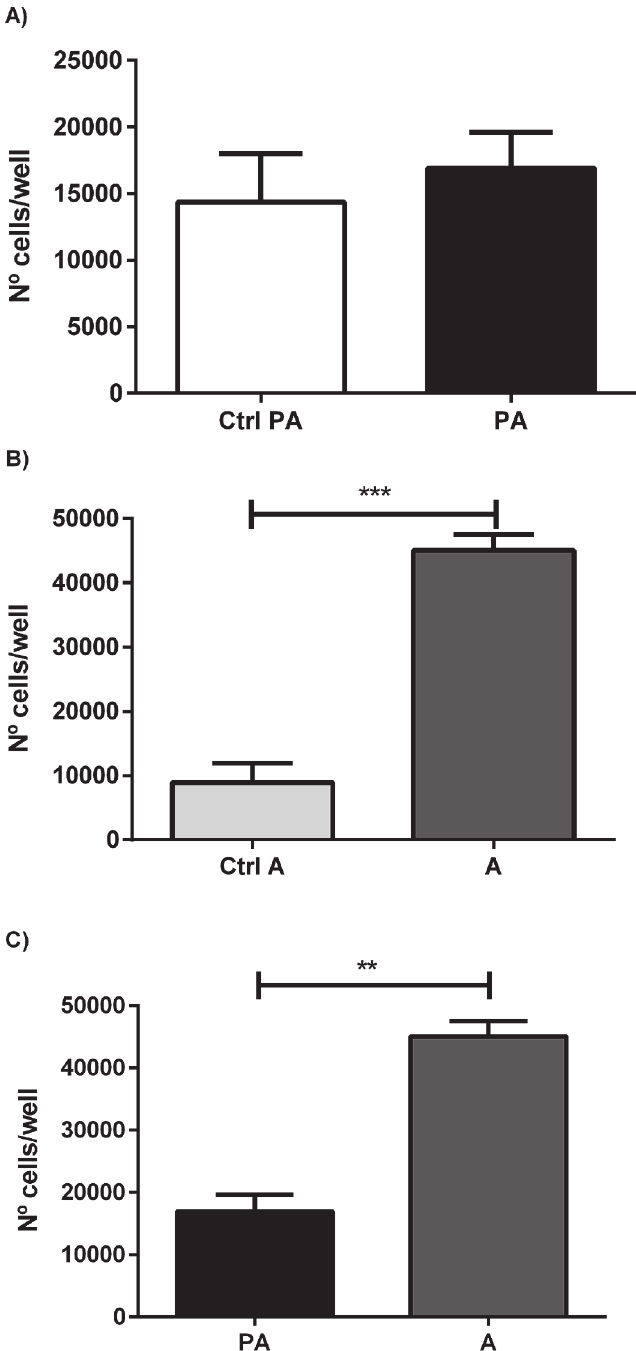
Fig 3. Cell proliferation assay in co-culture. Cellular proliferation was measured in RM1 co-cultivated with preadipocyte and adipocytes. Cell number/ well in different conditions tested, co-cultivated in the presence of preadipocytes (A) and adipocytes (B), all compared with the control, and comparing both conditions (C) ( ** p < 0.01; *** p < 0.001 Unpaired T test).